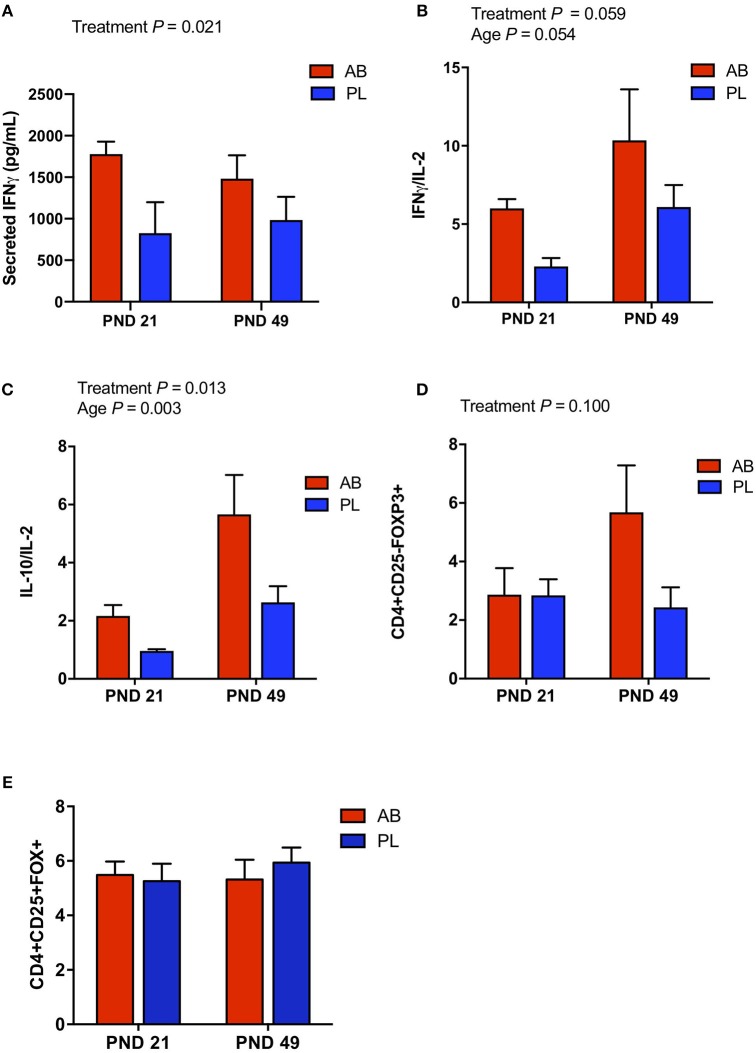
In vitro cytokine secretion and cell sub-populations of PBMC were affected by antibiotic (AB) treatment. PBMCs from AB and placebo (PL) treated pigs were stimulated in vitro with phytohaemagglutinin (PHA), a T cell mitogen. (A) Secreted IFNγ was higher in AB vs. PL treated pigs (Two-way ANOVA, Treatment P = 0.006, Age P = 0.022, Interaction P = 0.472). (B) The ratio of IFNγ/IL-2 tended to be higher in AB vs. PL treated pigs and tended to increase with age (Two-way ANOVA, Treatment P = 0.059, Age P = 0.054, Interaction P = 0.780). (C) The ratio of IL-10/IL-2 was higher in AB vs. PL treated pigs and increased with age (Two-way ANOVA, Treatment P = 0.013, Age P = 0.003, Interaction P = 0.248). (D) In addition, immune cell subpopulation CD4+CD25-FoxP3+, identified by flow cytometry, tended to be higher in AB treated pigs (Two-way ANOVA, Treatment P = 0.100, Age P = 0.220, Interaction P = 0.106. (E) However, the CD4+CD25+FoxP3+ immune cell subpopulation was not affected by treatment or age (Two-way ANOVA, Treatment P = 0.752, Age P = 0.684, Interaction P = 0.500). PND 21: AB n = 7, PL n = 7; PND 49: AB n = 7, PL n = 8; PND 84: AB n = 8, PL n = 7.